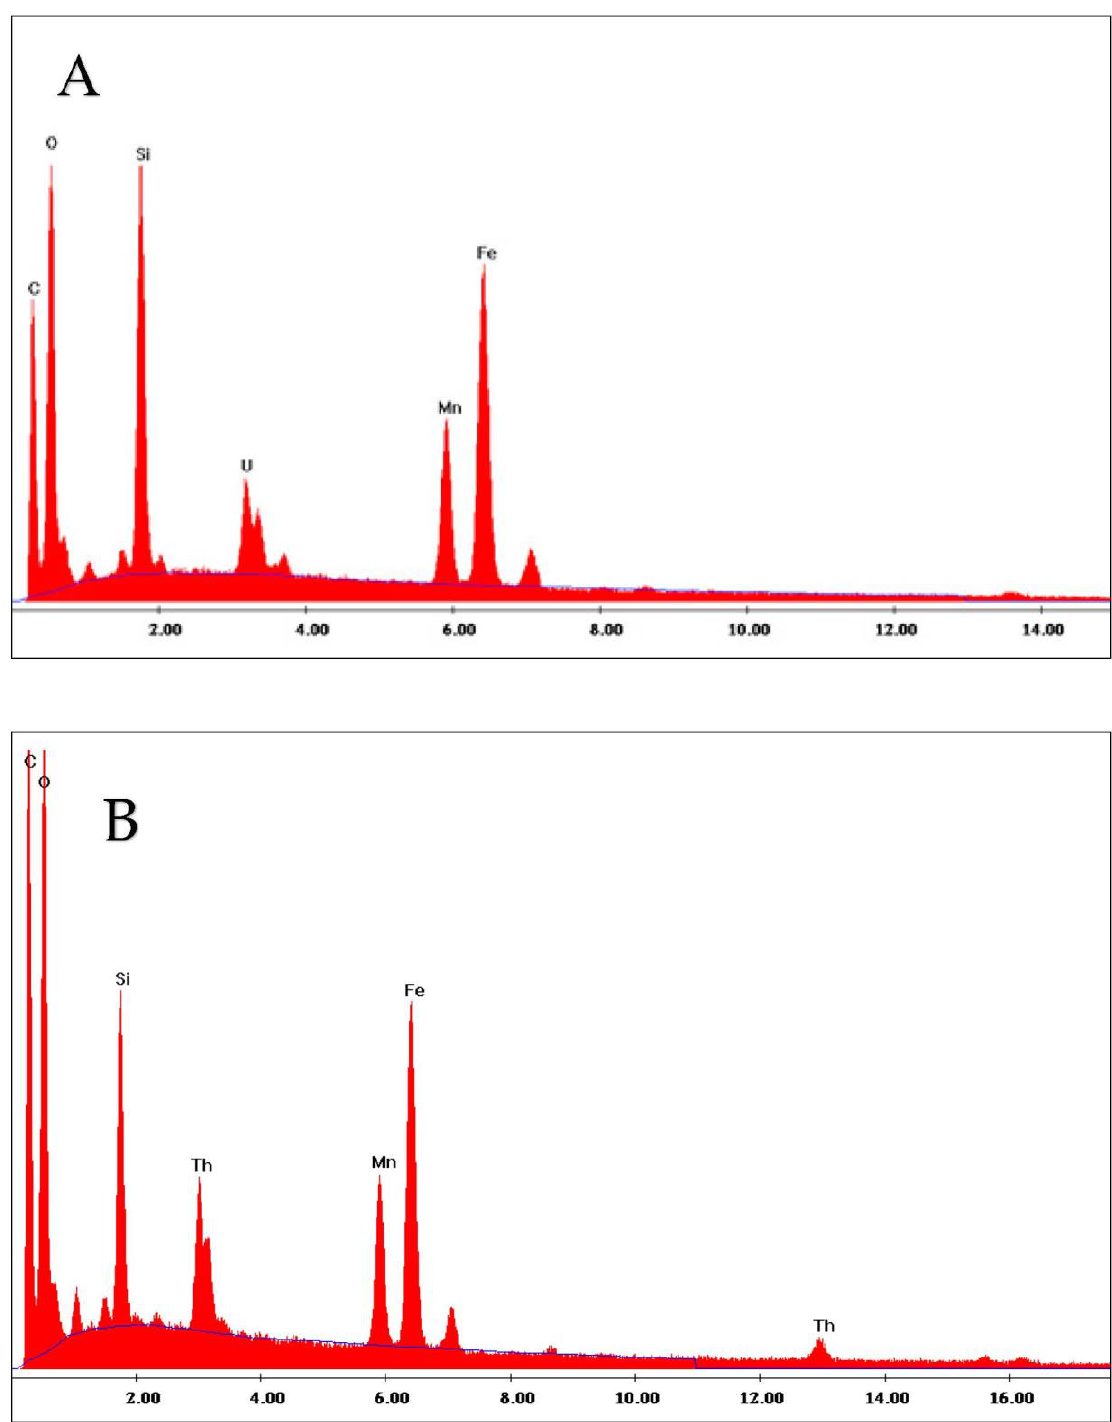
Figure 7. EDS for ( A ) CCsMFO/U(VI) and ( B ) Table 1. CCsMFO particle size.